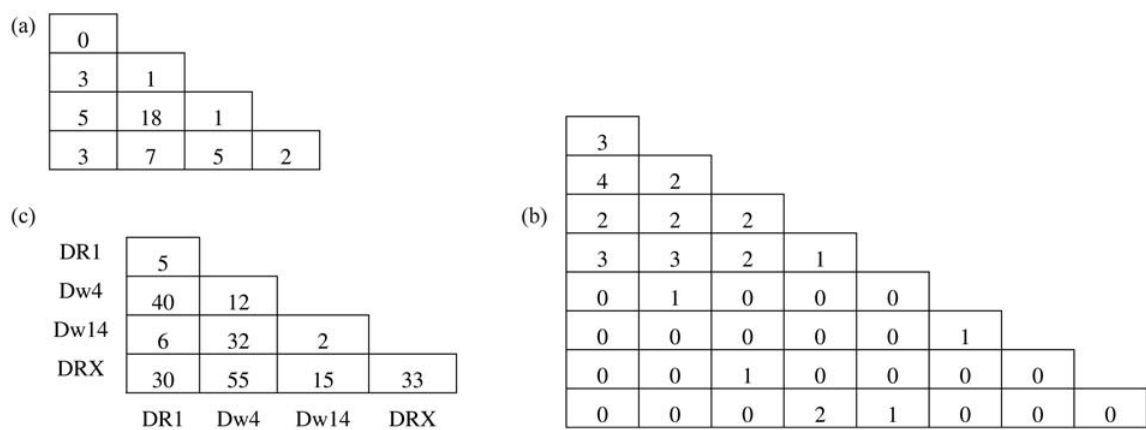
Figure2 -Datasetsfornumericalexperiments,givenbyLouisandDempster(1987)(a),GuoandThompson(1992)(b)andWordsworth etal.